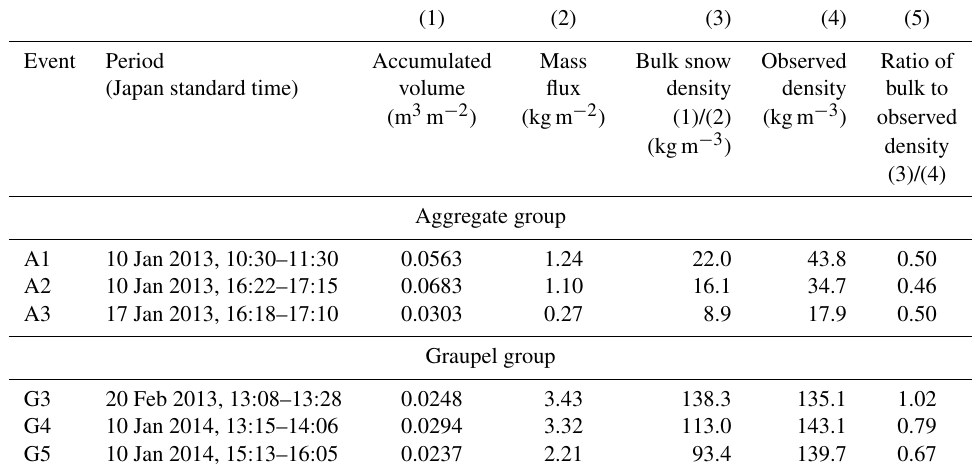
Table 2. Selected snowfall events and bulk snow density calculated from disdrometer data. Bulk snow density was calculated from total mass flux divided by accumulated volume flux. The ratio between calculated and observed bulk snow density is also